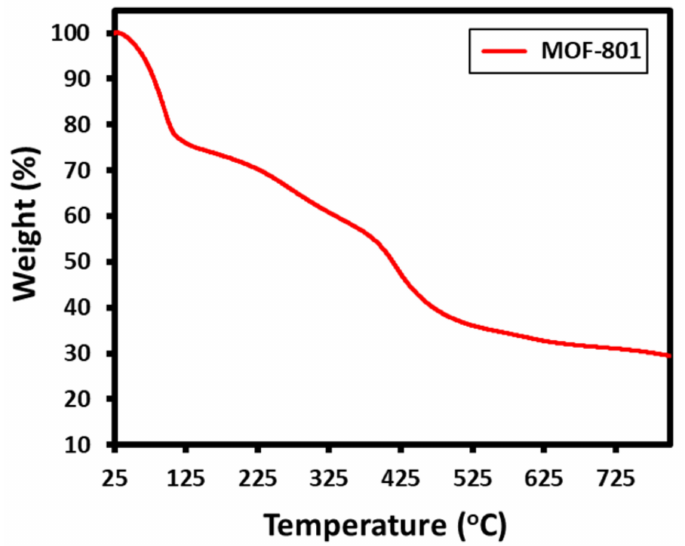
Figure 3. TGA analysis of